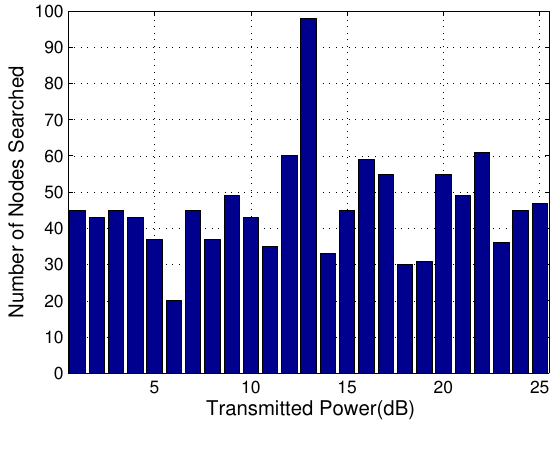
Figure 4. The number of nodes searched via the branch-and-bound algorithm versus transmitted power in the scenario of Figure 2.